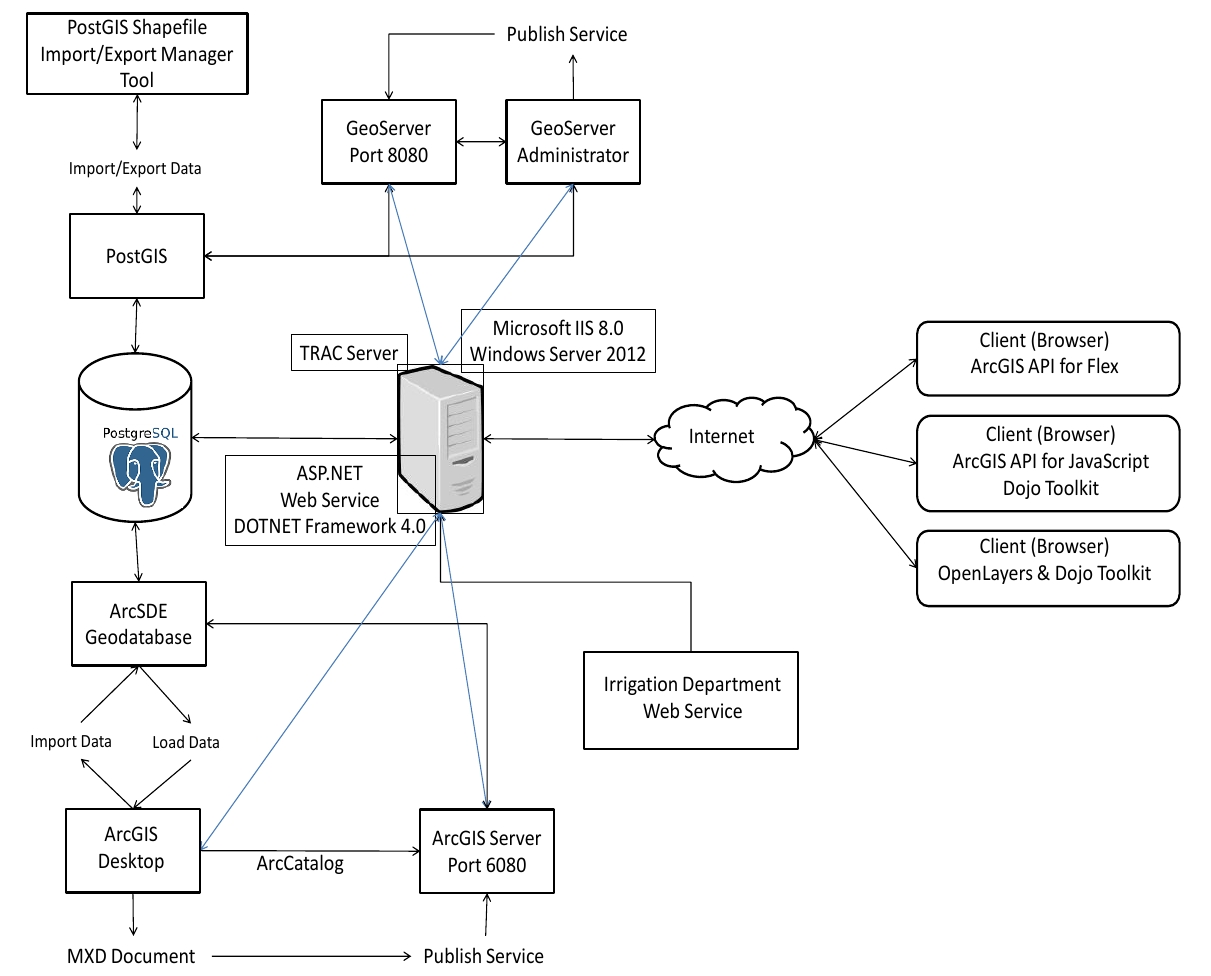
Figure 1 : Tank Information System